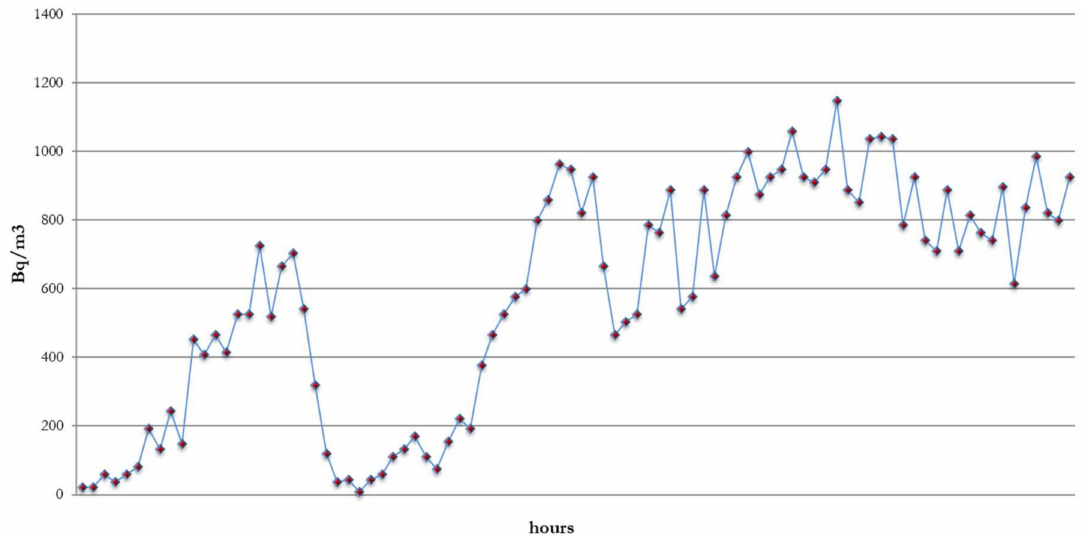
Figure 1. Radon concentration during the 72-h detection in Room number 3.